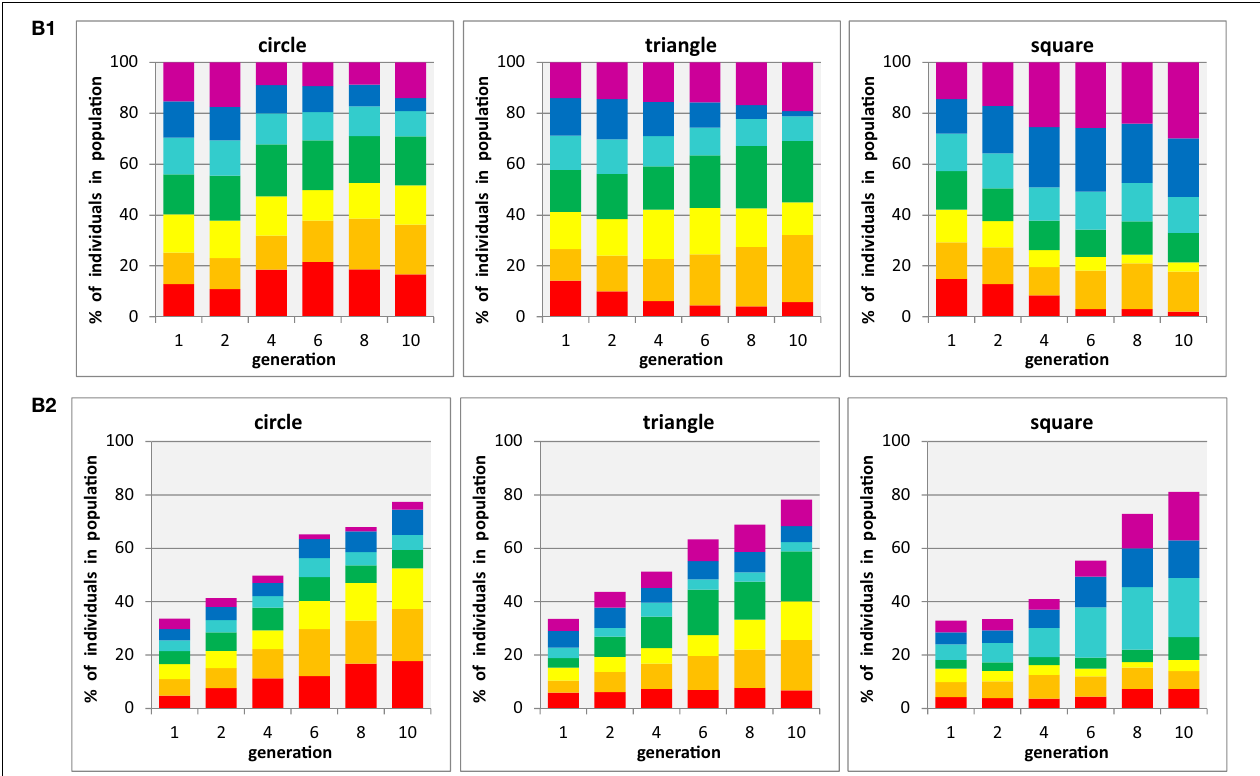
FIGURE 4 | Evolution of populations with three shapes × seven colors. (B1) three shapes are tested in separate populations containing a single shape each (i.e., participants are asked to select the preferred individual from seven color-shape combinations with identical shape). (B2) three shapes are tested in mixed populations containing all shapes (i.e., participants select the preferred color-shape combination of a given shape in the presence of both